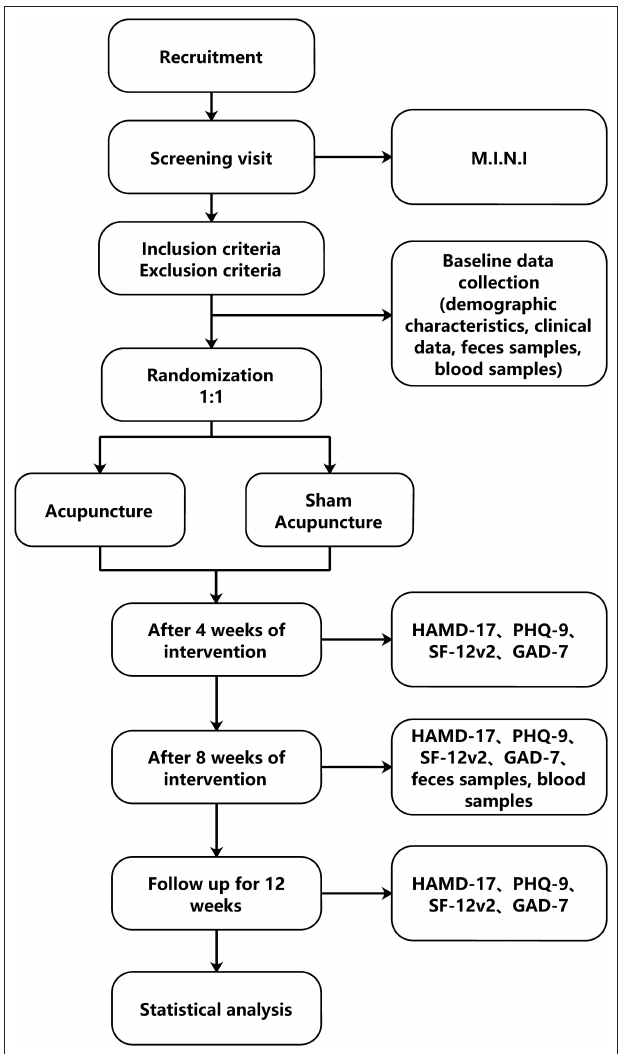
FIGURE 1 | Flow chart of study design. M.I.N.I, Mini International Neuropsychiatric Interview; HAMD-17, Hamilton Depression Scale-17; PHQ9, The 9-item Patient Health Questionnaire; GAD-7, 7-item Generalized Anxiety Disorder; SF12v2, SF-12v2 Health